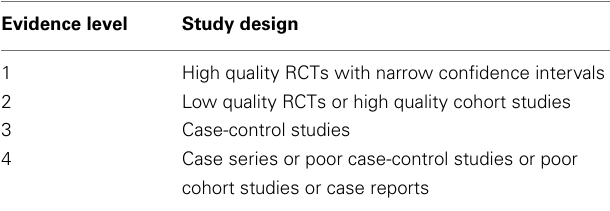
Table 3 |Table showing levels of evidence for randomized controlled trials (based on Oxford Center for Evidence-based